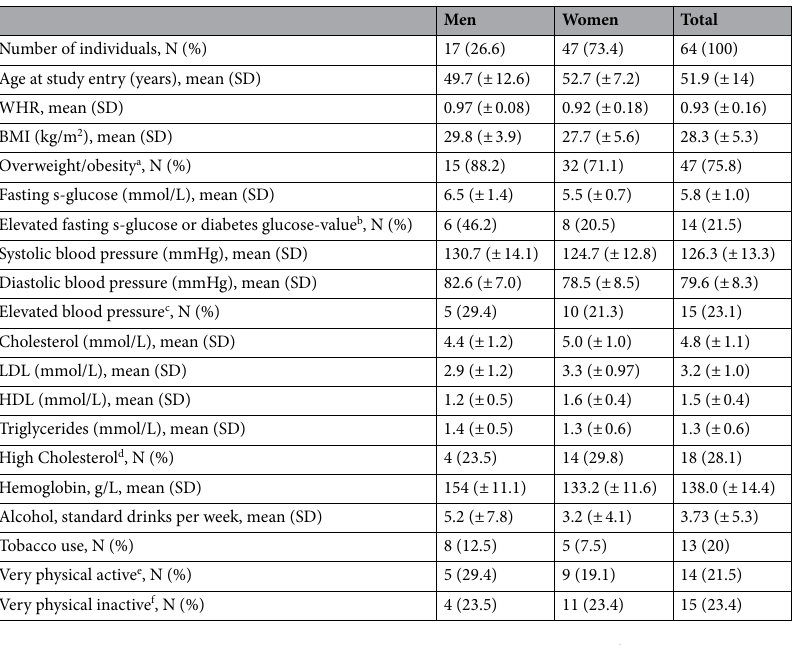
Table 1. Characteristics of the study cohort, n = 64. a BMI ≥ 25 kg/m 2 ; b > 6.0 mmol/l; c > 140/90 mmHg; d > 5 mmol/L; e risk level 1; f risk level 4.